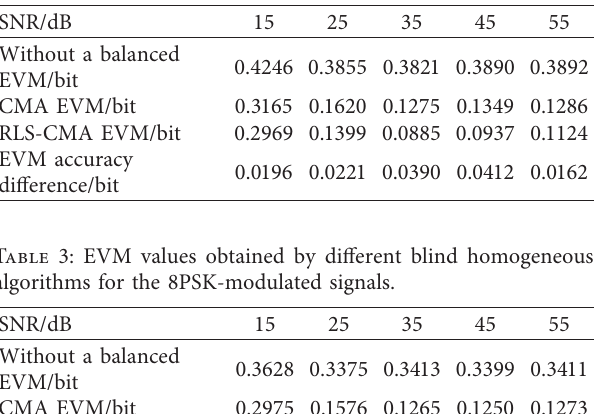
Table 2: EVM values obtained by different blind homogeneous algorithms for the QPSK-modulated signals.